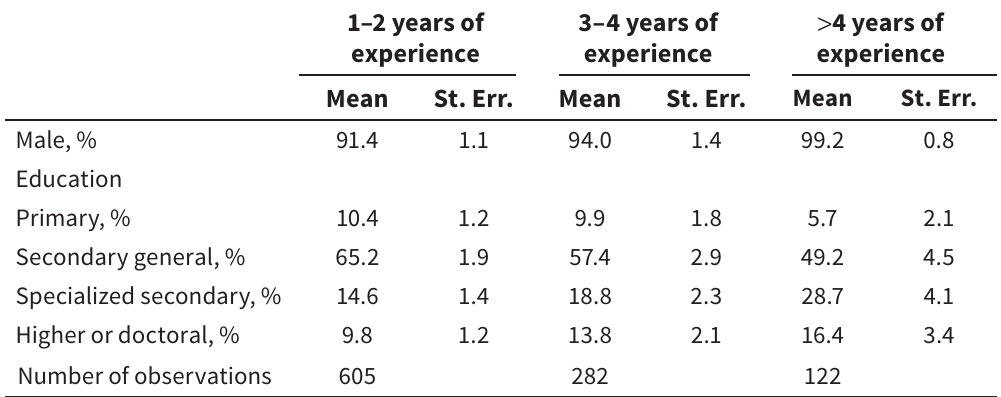
Migrant characteristics by years of migration experience 1–2 years